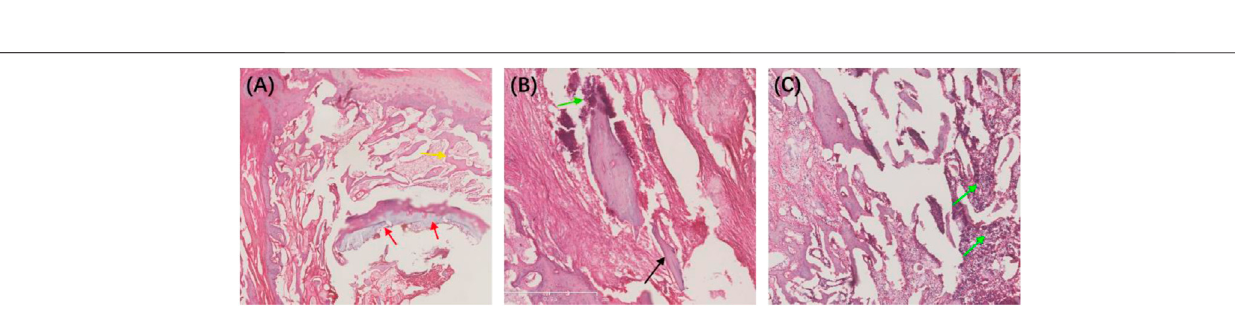
FIGURE 10 | X-rays of chronic-osteomyelitis-mode. treatment group (A) , control group (B) and blank group (C) after 28 days of treatments.